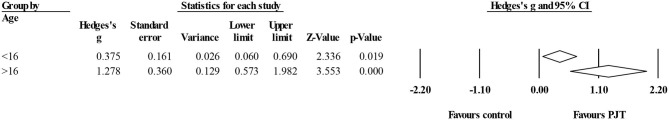
Forest plot of changes in countermovement jump performance in volleyball players (by years of age: <16 vs. ≥16) participating in plyometric jump training (PJT) compared to controls. Values shown are effect sizes (Hedges's g) with 95% confidence intervals (CI).